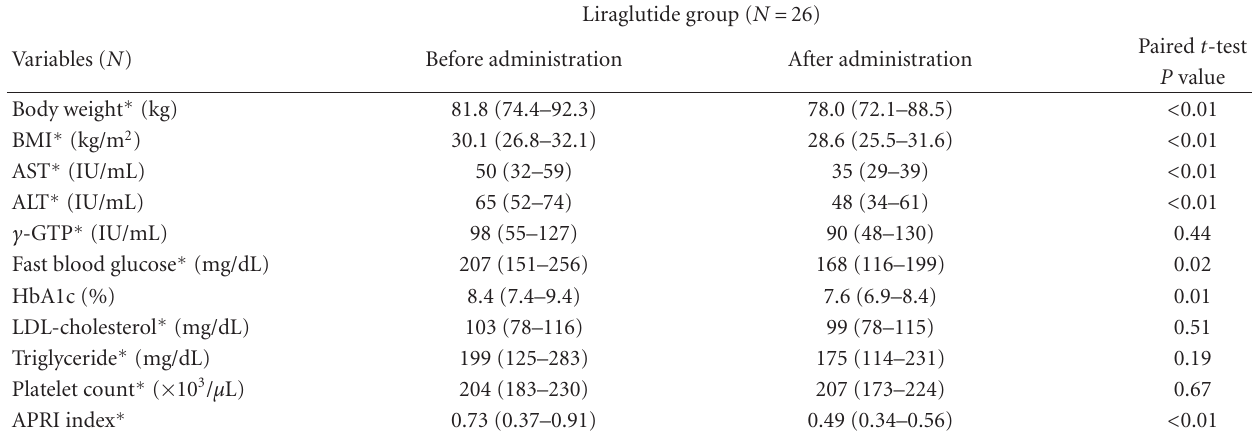
Table 2: Change of parameters after administration of liraglutide. Liraglutide group ( N =